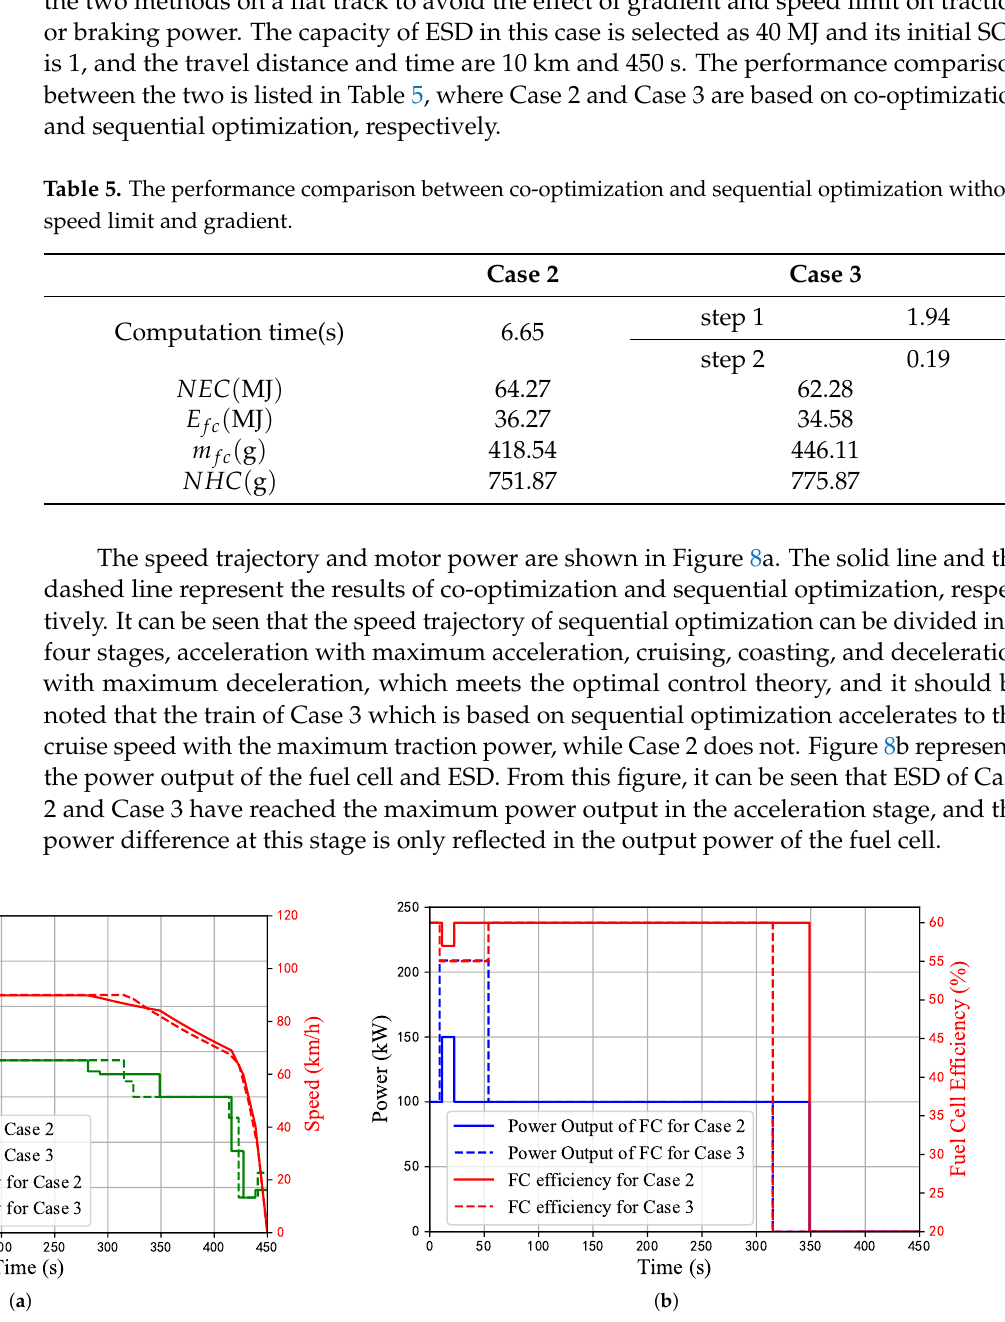
Figure 8. ( a ) The comparison of motor power. It can be seen that the train in Case 3 accelerates to cruising speed with the maximum acceleration, while the one in Case 2 does not. ( b ) The comparison of power output and the instant efficiency of the fuel cell. The fuel cell in Case 3 outputs higher power but works with generally lower